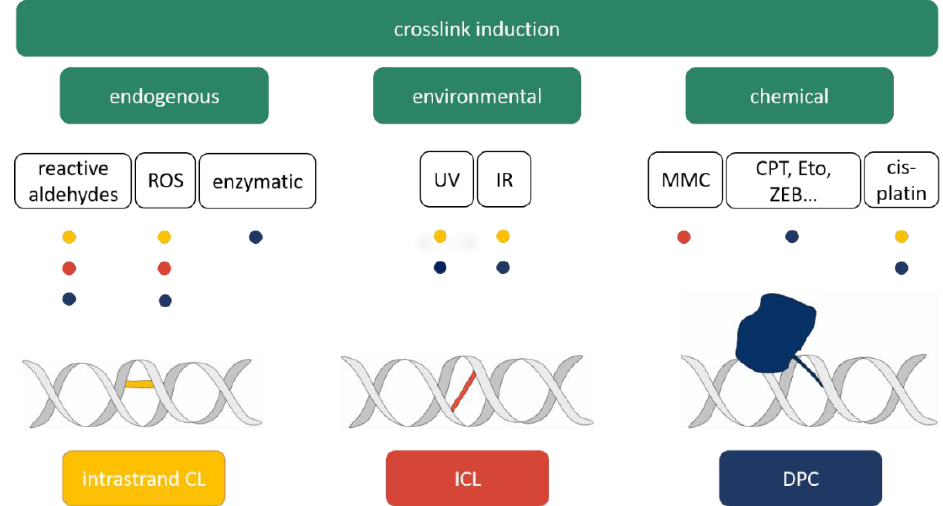
Figure 1. Overview on the origin of different types of crosslinks. The different origins of CL induction by endogenous, environmental and chemical factors are summarized. Reactive aldehydes, reactive oxygen species (ROSs) and stabilization of enzymatic reaction intermediates are able to endogenously produce CLs. UV and ionizing radiation (IR) are environmental CL sources. Chemical crosslinkers form the third category, including mitomycin C (MMC), camptothecin (CPT), etoposide (Eto), zebularine (ZEB) and cis-platin. The colored dots provide information on the type of induced CL. Intrastrand CL: yellow; ICL: orange; DPC: blue.